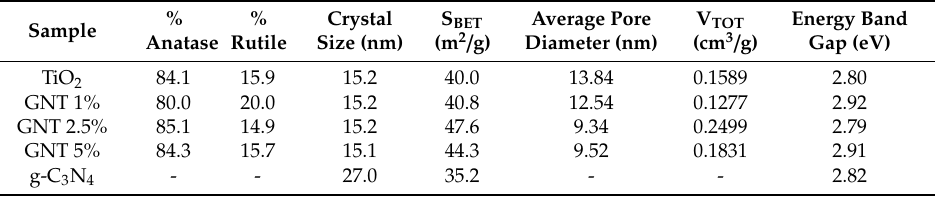
Table 1. Physicochemical properties of calcinated g-C 3 N 4 / TiO 2 and g-C 3 N 4